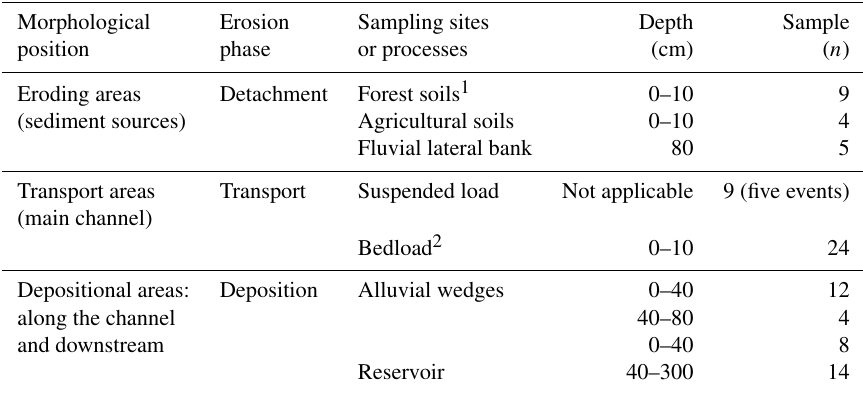
Table 1. Characteristics and representativeness of soil and sediment samples at the different morphological positions representing the different phases of the erosion process across the